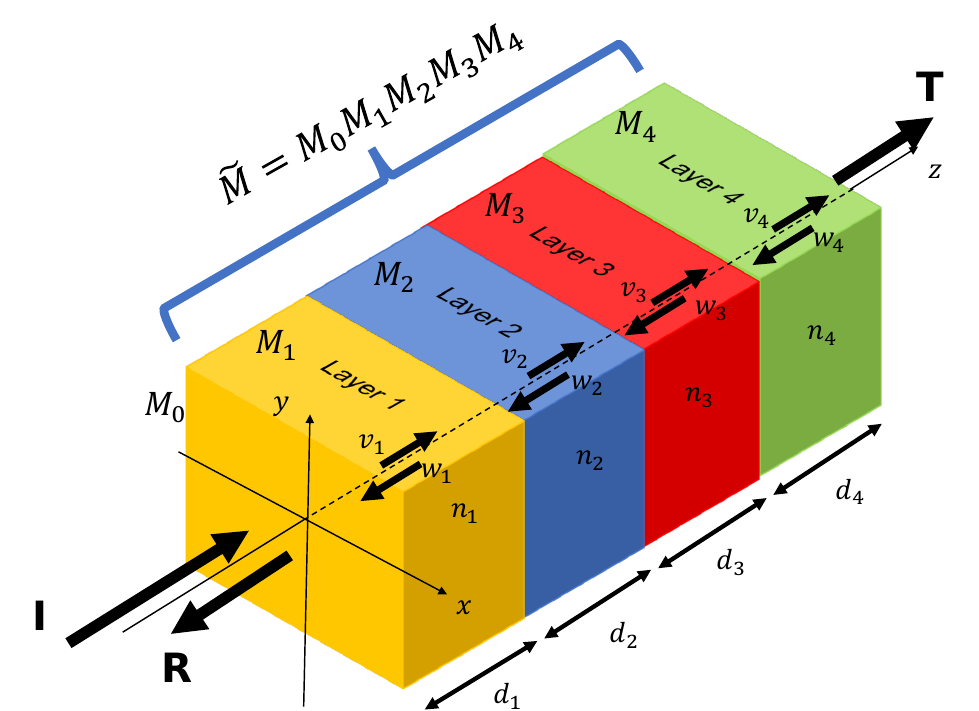
Figure 2. The example of an optical thin film stack comprises layer1-layer2-layer3-layer4. The I is the incoming incident light, and T and R represent the transmitted and reflected light. The n j depicts the refractive index of each layer material, and d j is the thickness of each layer. The transfer characteristic of each thin layer is represented by M j